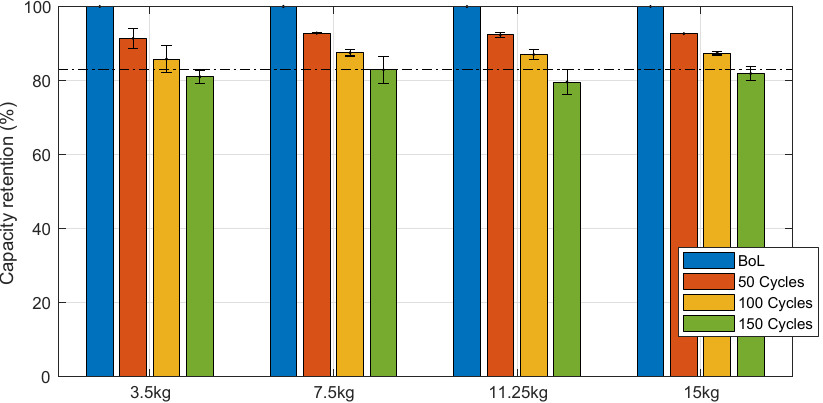
Figure 5. Influence of the initial applied perpendicular pressure on Si-alloy cell’s capacity retention, where the black horizontal line indicates the optimum capacity retention after 150